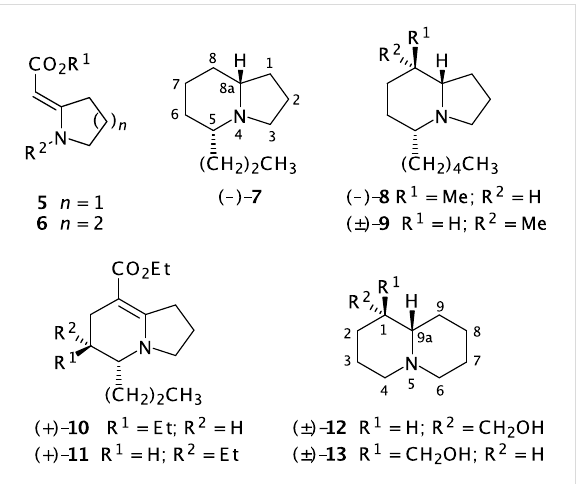
Figure 2: Indolizidines and quinolizidines prepared from enaminone precursors 5 and 6 . The conventional numbering scheme for both bicyclic systems is also